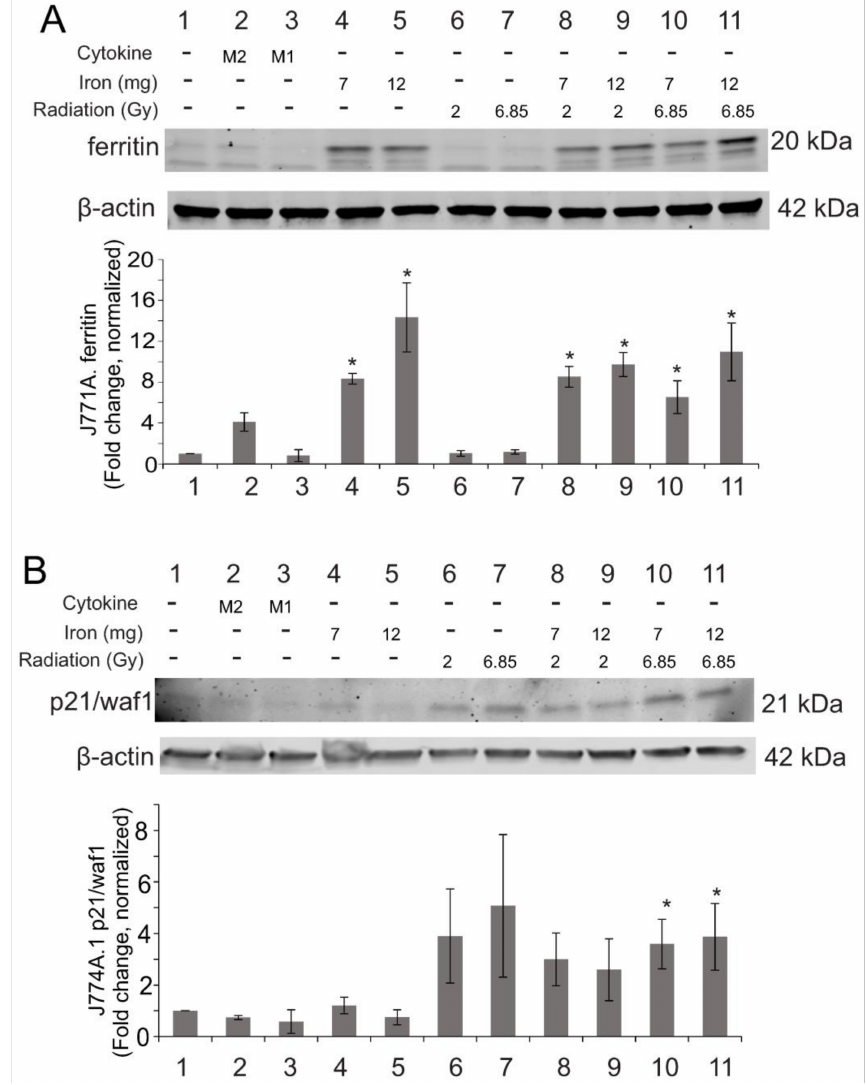
Figure 11. Effects of radiation and high iron concentrations on J774A.1 murine macrophage ex- pression of ferritin and senescence in culture. J774A.1 cells were grown to ~80% confluence, and untreated (control) exposed to either 7 or 12 mg/L Fe 3+ and/or 2 or 6.85 Gy X-ray irradiation. As a control for M2 polarization, cells were treated with 100 ng/mL IL-4; as a control for M1 polarization, cells were treated with 100 ng/mL IFN- γ + 100 ng/mL LPS. 24 h post-irradiation, Protein was purified and used for western blots for ferritin ( A ) or p21/waf1 ( B ). Blots were probed for β -actin as a loading control. Protein levels were normalized to β -actin and then the relative expression was determined compared with control levels. Graphs show means ± SEM, n = 3 independent experiments. * indicates p < 0.05 compared with